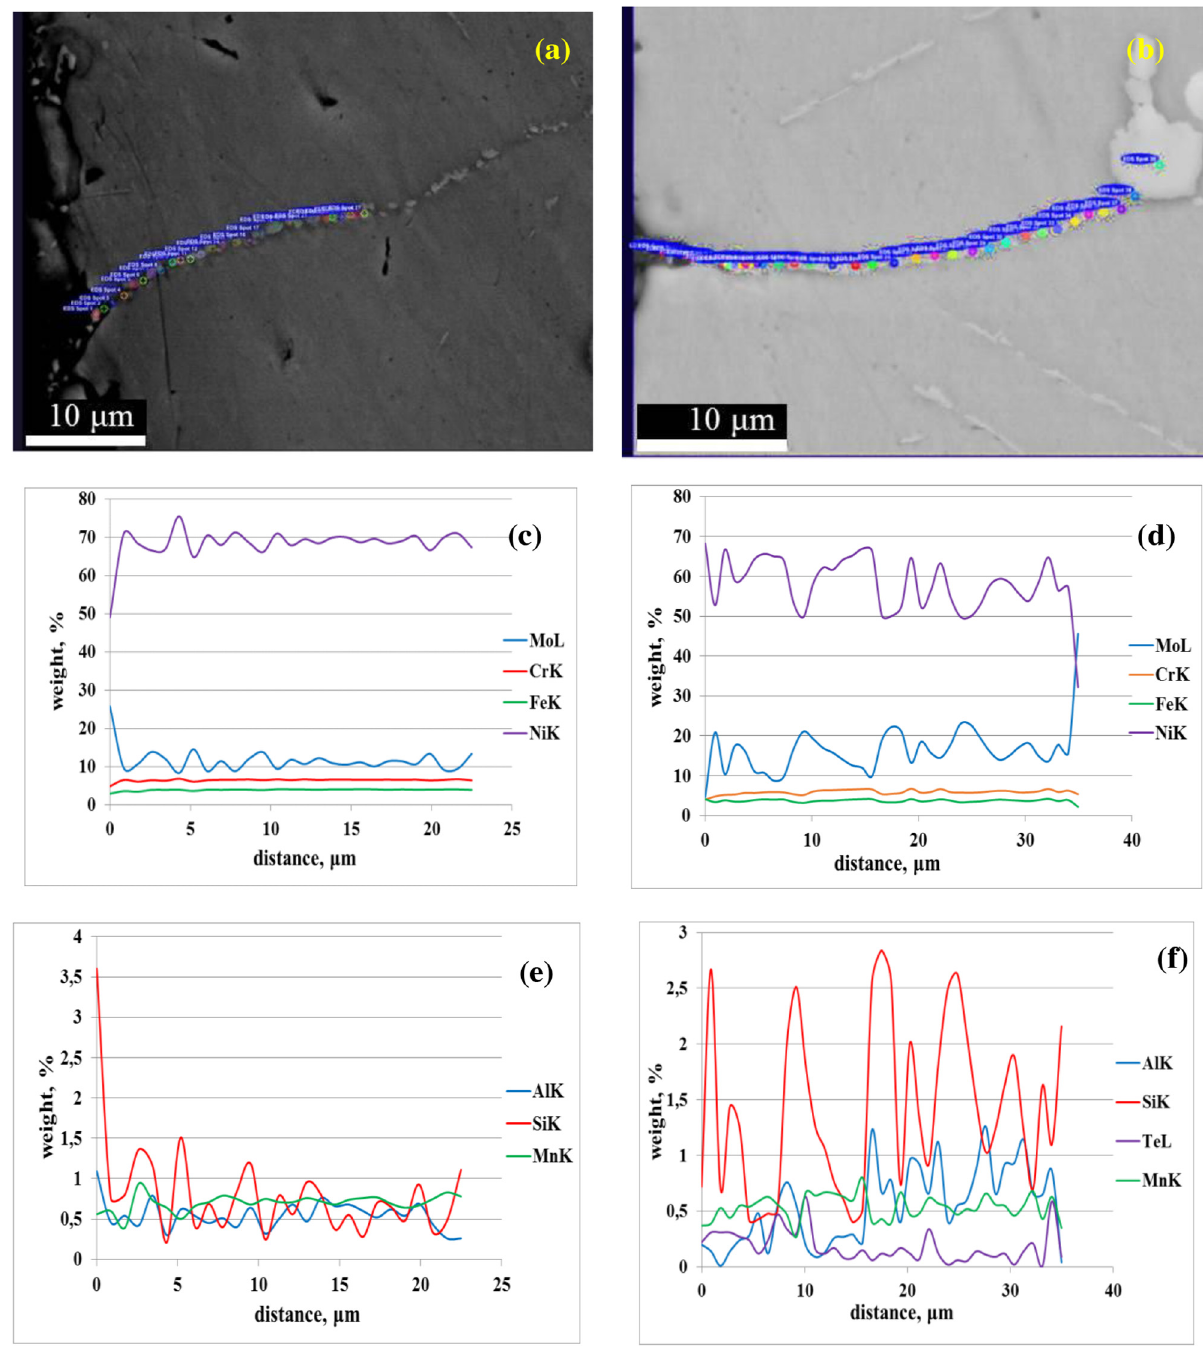
Fig. 8. Scanning data for the under surface of the Hastelloy-N along the grain boundary exposed in the fuel salt, (a), (c), (e) scan line, the concentration of the main metal and alloying additives in the specimen, after test with [U(IV)]/[U(III)] ratio 42 at T = 760 ° C (left), (b), (d), (f) scan line, the concentration of the main metal and alloy additive in the specimen, after test with [U(IV)]/[U(III)] ratio 85 at T = 800 ° C